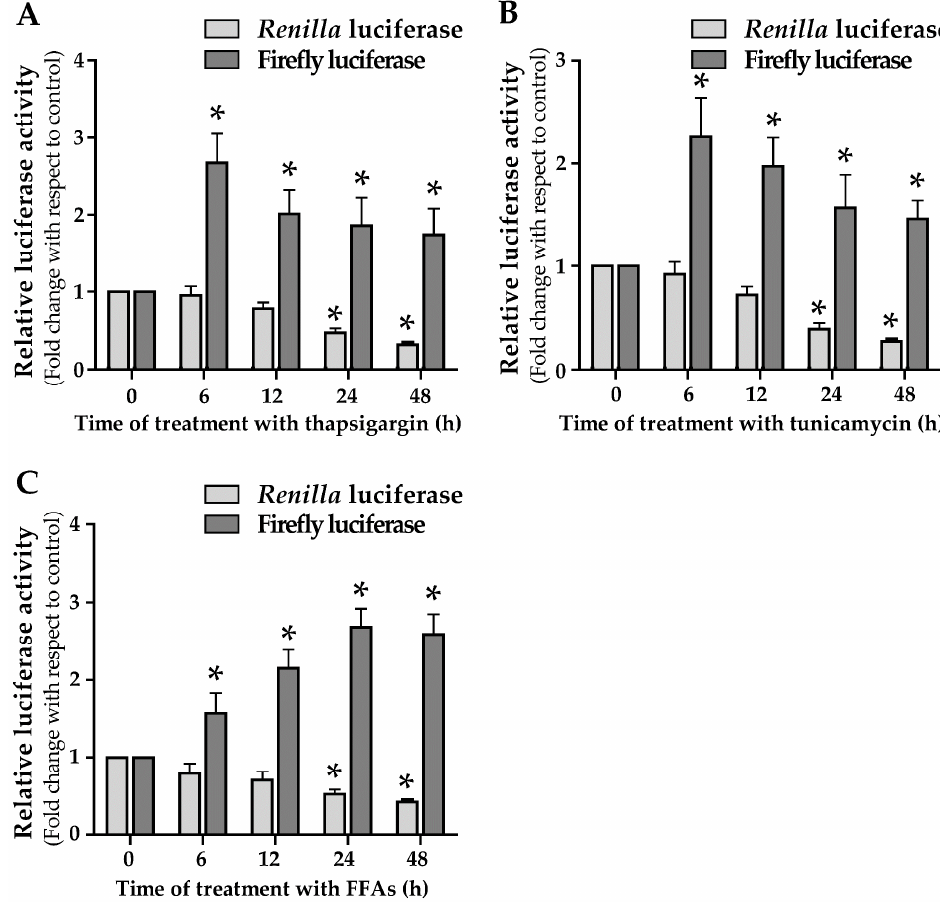
Figure 6. IRES activity is stimulated in ER-stressed cells or in cells under treatment with FFAs. ( A , B ) HepG2 cells were co-transfected with the reporter plasmid pR-ACLY-F and with the control plasmid pCMV-SPORT- β -gal. After 24 h, cells were treated with thapsigargin ( A ) or tunicamycin ( B ) for the indicated times and then RL and FL luciferase activities were measured. For each sample, values were reported in histograms as fold change with respect to control, represented by untreated transfected cells. Values are means ± S.D., n = 6 (0 h vs. 6 h, 12 h, 24 h, and 48 h * p ≤ 0.05). ( C ) HepG2 cells were transiently transfected with pR-ACLY-F. After transfection, cells were incubated in the presence or in the absence of 0.75 mM FFAs. Luciferase activity measured in cells treated with FFAs is reported as fold change with respect to that determined in untreated transfected cells. Values are means ± S.D., n = 6 (0 h vs. 6 h, 12 h, 24 h, and 48 h * p ≤